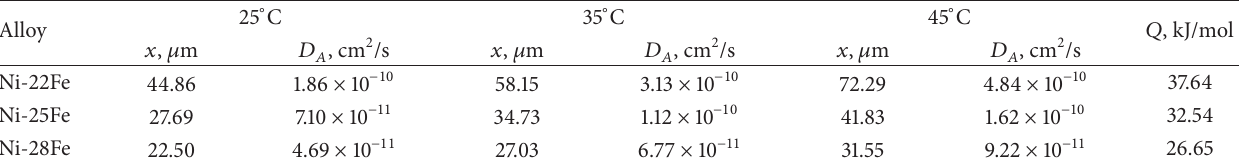
Fe alloy with different stoichiometry precharged hydrogen at various conditions. 3